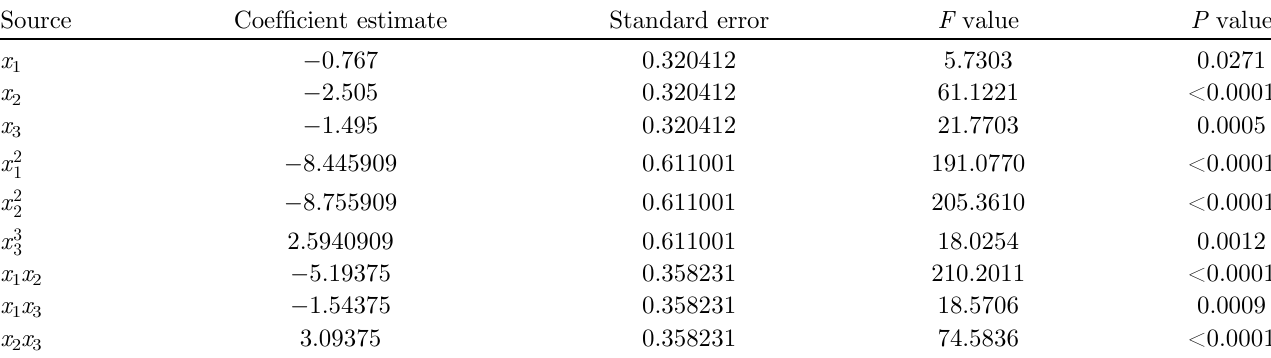
Table 4. Estimated regression coef fi cients for FAEE (%)